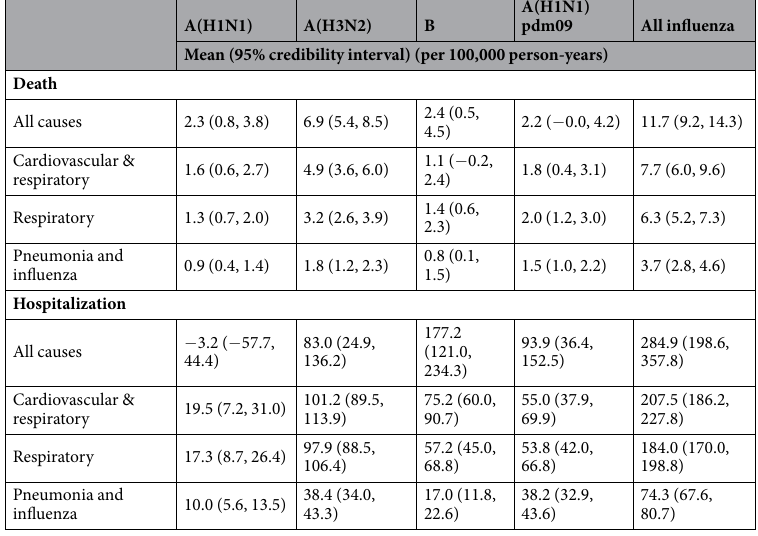
Table 2. Average annual influenza-associated excess mortality and hospitalization rates from all causes, cardiovascular and respiratory diseases and pneumonia and influenza by virus type and subtype in Hong Kong population from January 1998 through June